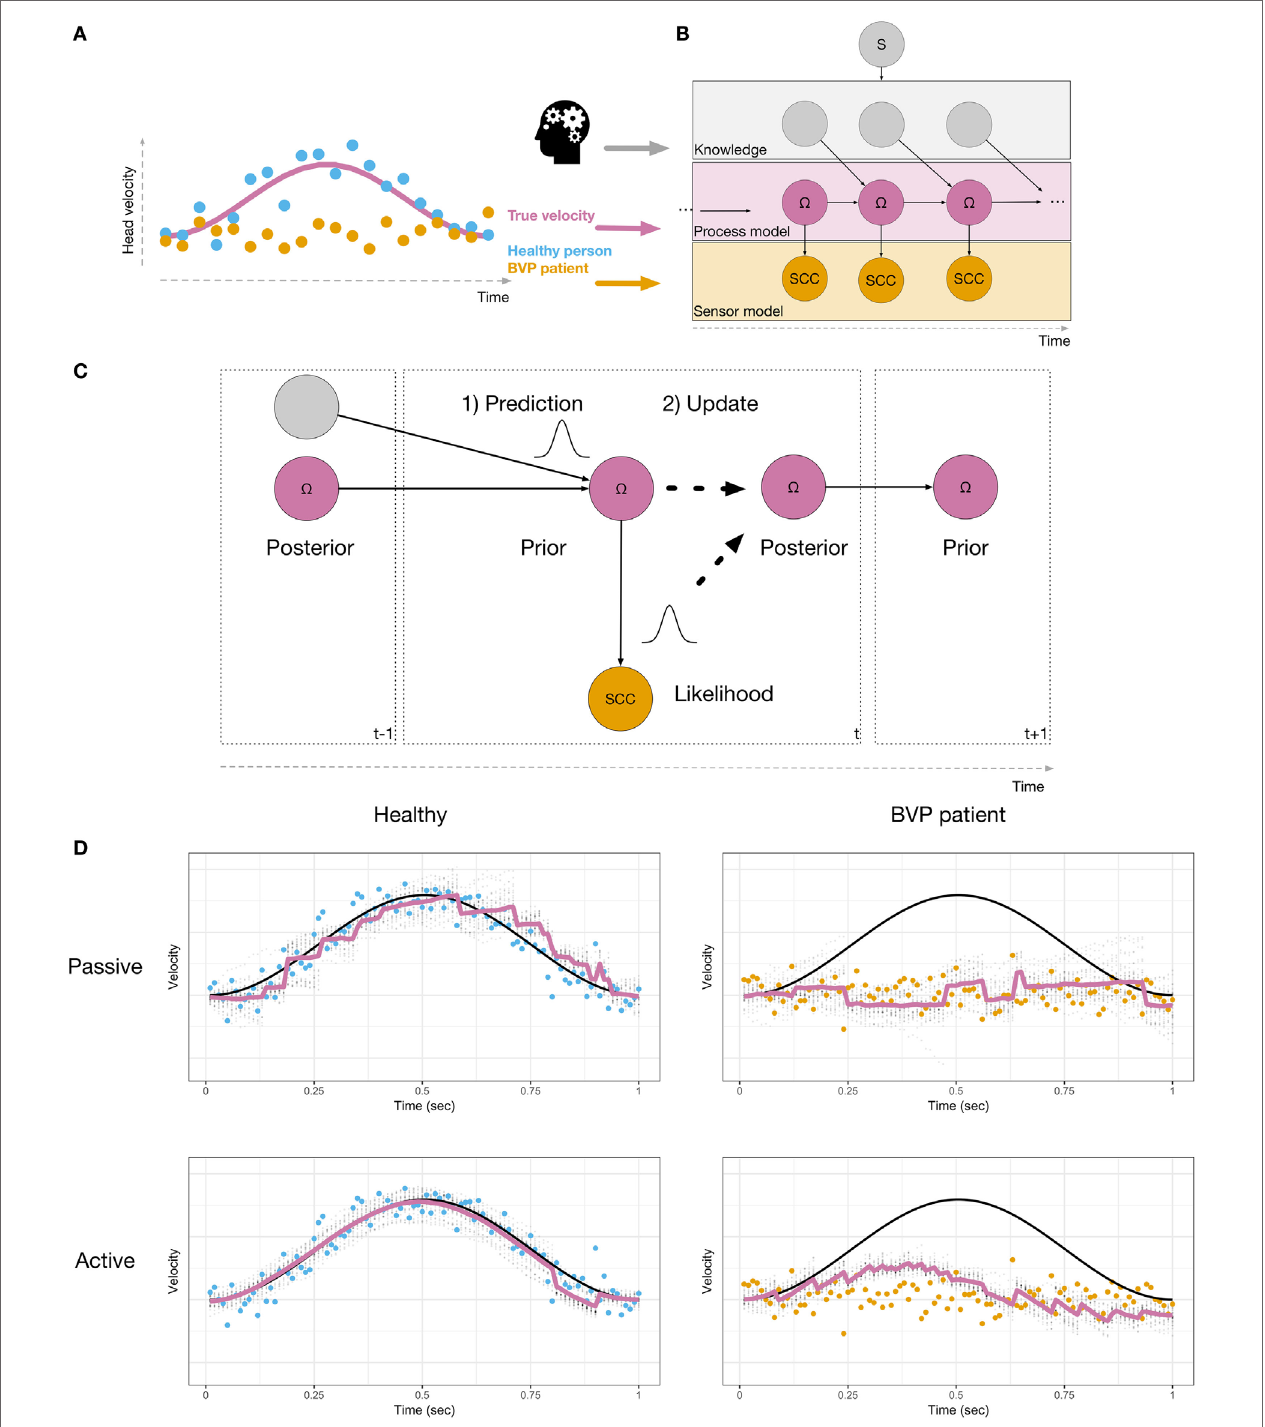
FigUre 1 | (A) Head velocity, shown as a pink line, during a left head turn. Sensory signals are shown in blue for a healthy person, and in orange for a BVP patient. (B) Probabilistic model used to perform sensory inference. The velocity Ω (pink nodes) is represented as a sequence of latent states, which need to be inferred, given the sensory observations (orange nodes). Additional knowledge (gray nodes, e.g., derived from motor commands or higher-level knowledge) are used in order to predict Ω . The model includes a binary switch S (gray node), which indicates whether or not knowledge is used (active or passive). (c) During inference, the current state is probabilistically predicted (1), based on the posterior from the previous time step and additional knowledge. The prediction is then updated with the likelihood (2), resulting in a posterior state estimate. This is repeated at every time step. (D) Simulations of a healthy person (left) and a BVP patient (right) using a particle filtering algorithm and the generative model shown in (B) . True velocity is shown in black. Sensory observations are shown as blue (healthy) or orange (BVP patient) dots. Estimated velocity is shown as a pink line, along with the uncertainty in the estimate (gray dots).